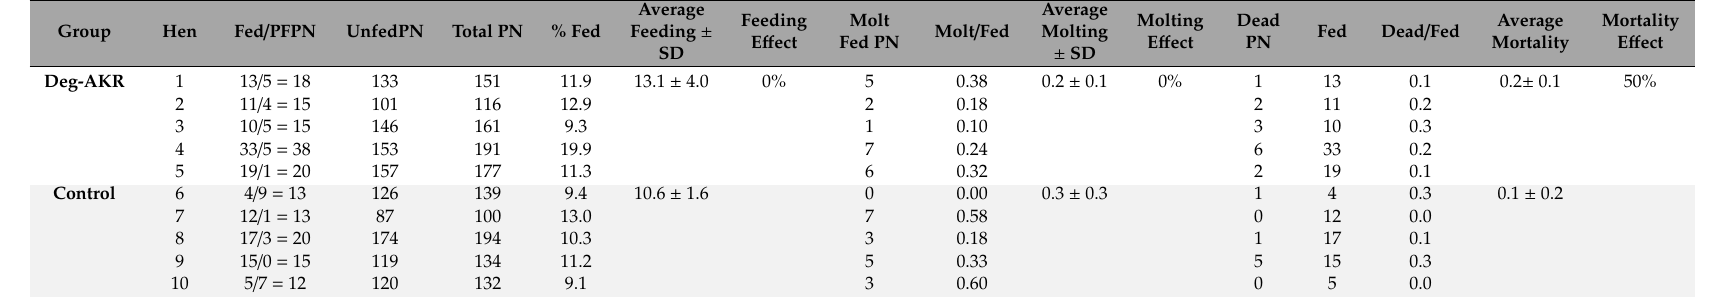
Table 2. Summary of protonymphs PRM feeding and molting rates and vaccine e ffi